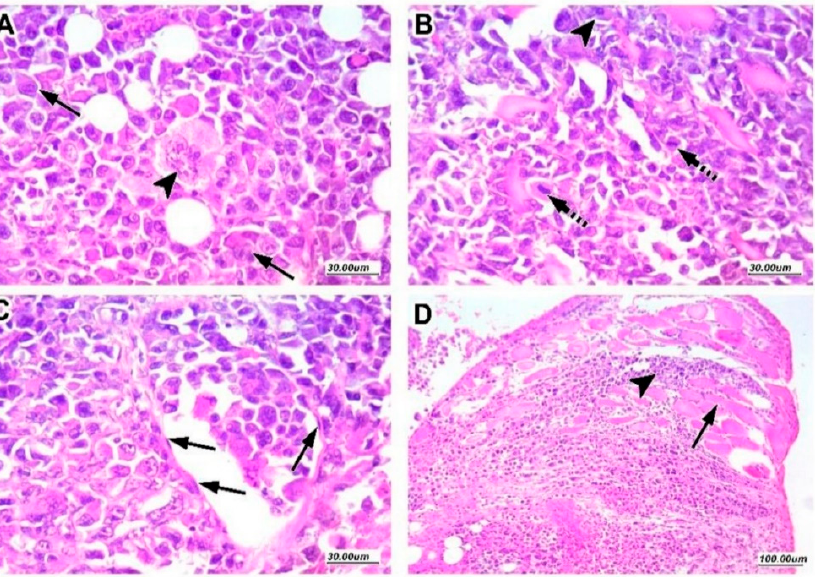
Figure 3. Western blotting for the target proteins. Panel ( A ): gels for the (1,3) EST + combination group; (2) EST control group, (4,5) EST + α -hederin group, (6,7) EST + cisplatin group. Panel ( B ): Column chart for SDF1 Panel ( C ): column chart for CXCR4 and Panel ( D ): column chart for p-AKT. *: versus EST control, &: versus EST + α -hederin group, ∆ : versus EST + cisplatin group. Data are mean ± SD and statistically analyzed at p < 0.05.